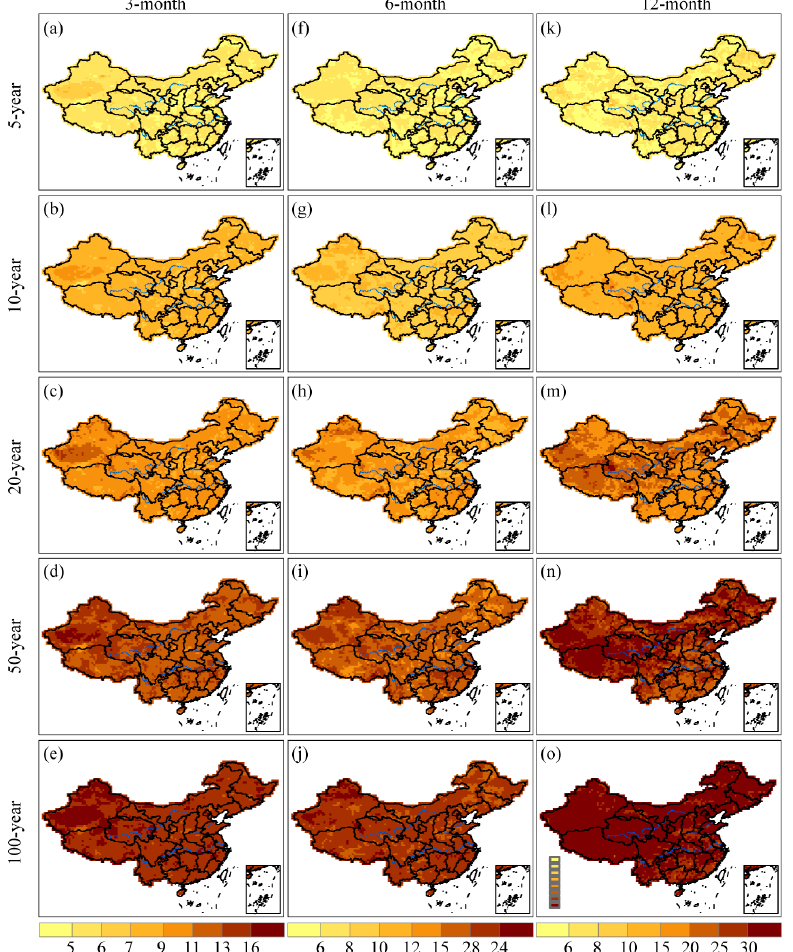
Figure 5. Spatial distributions of drought duration with 5-, 10-, 20-, 50-, and 100-year return periods based on SPI-3, SPI-6, and SPI-12 values. Specifically, ( a – e ) in each panel show the spatial patterns of drought duration with return periods of 5-, 10-, 20-, 50-, and 100-year at the 3-month time scale; ( f – j ) in each panel depict the corresponding patterns at the 6-month time scale; and ( k – o ) in each panel illustrate the patterns at the 12-month time scale.